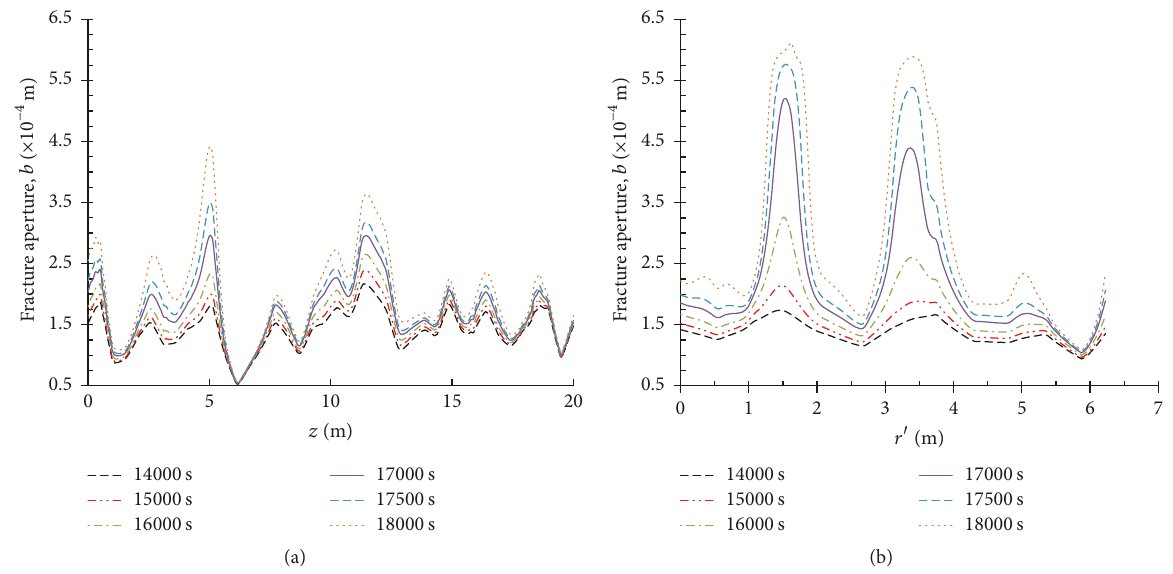
Figure 15: Evolution of fracture aperture along the lines of (a) O-O 󸀠󸀠 axis and (b) O 󸀠 -A 󸀠 axis.